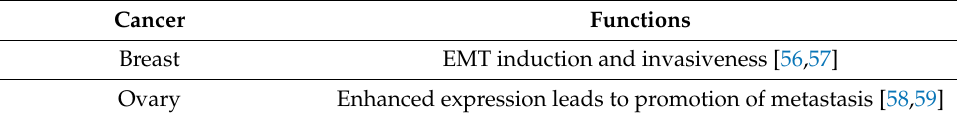
5. Integrin α v β 6 as a Target for Imaging and Therapy